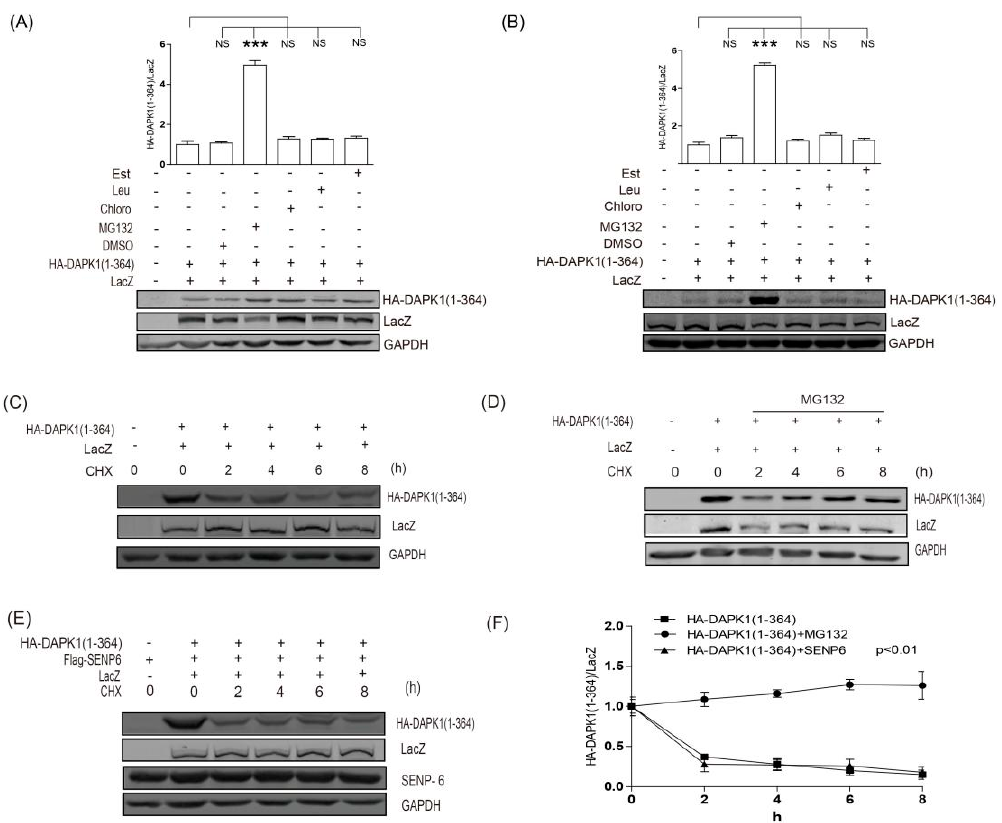
Figure 4. SUMO pathway did not regulate the protein degradation of HA-DAPK1 (1–364). ( A ) HEK293T cells or ( B ) HCT116 cells transfected with DAPK1 (1–364) and LacZ were exposed to MG132 (10 μ M, 6 h) or leupeptin (200 μ M), Est (10 μ g/mL) and chloroquine (100 μ M) for 24 h as indicated. ( C ) HEK293T transfected with LacZ, DAPK1(1–364) were exposed to 20 μ g/mL CHX for 0–8 h as indicated. ( D ) HEK293T transfected with HA-DAPK1 (1–364) and LacZ were exposed to 10 μ M MG132 and 20 μ g/mL CHX for 0–8 h as indicated. ( E ) HEK293T transfected with LacZ, HA-DAPK1 (1–364) and Flag-SENP6 were exposed to 20 μ g/mL CHX for 0–8 h as indicated. The statistical results